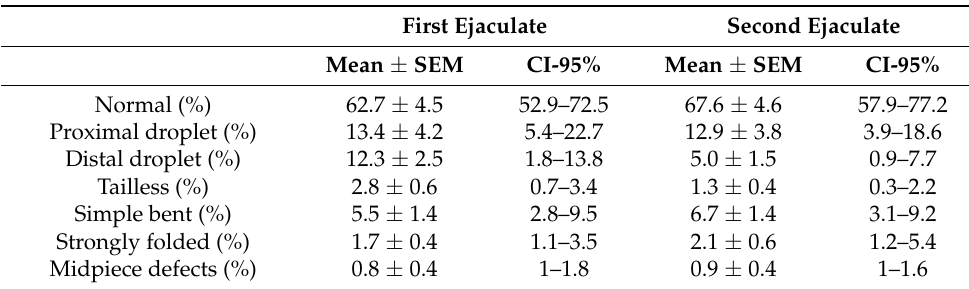
Table 4. Sperm morphology of the first and second ejaculates of the season collected from 20 breeding inactive stallions.